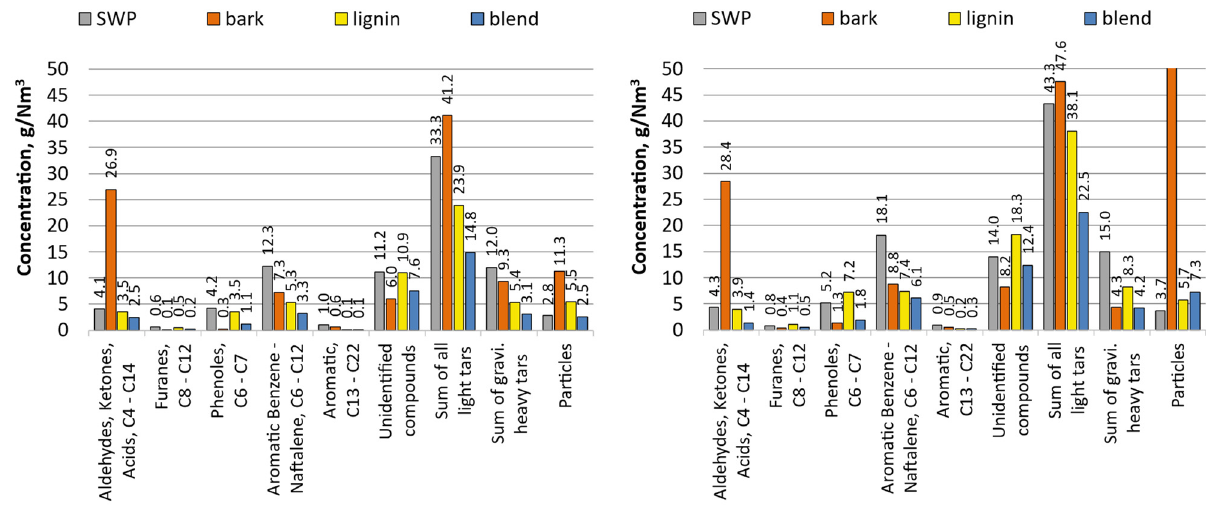
Figure 4. Composition of tars with a division for the main classes of compounds for 1 bar g and 5 bar g tests (left and right, respectively).